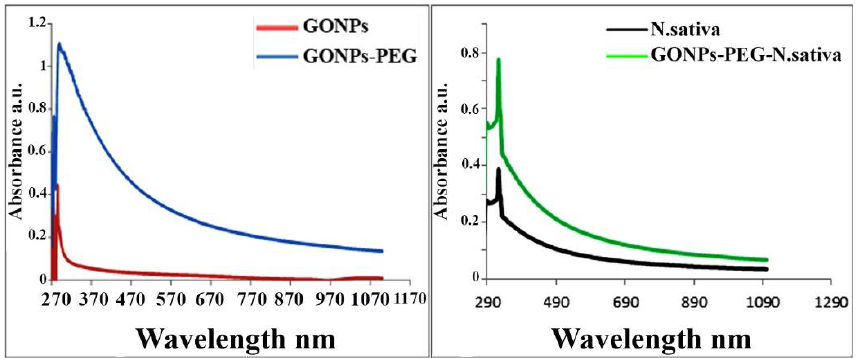
Figure 6. UV-vis absorption spectrum of GONPs, GONPs-PEG, N. sativa , GONPs-PEG- N. sativa